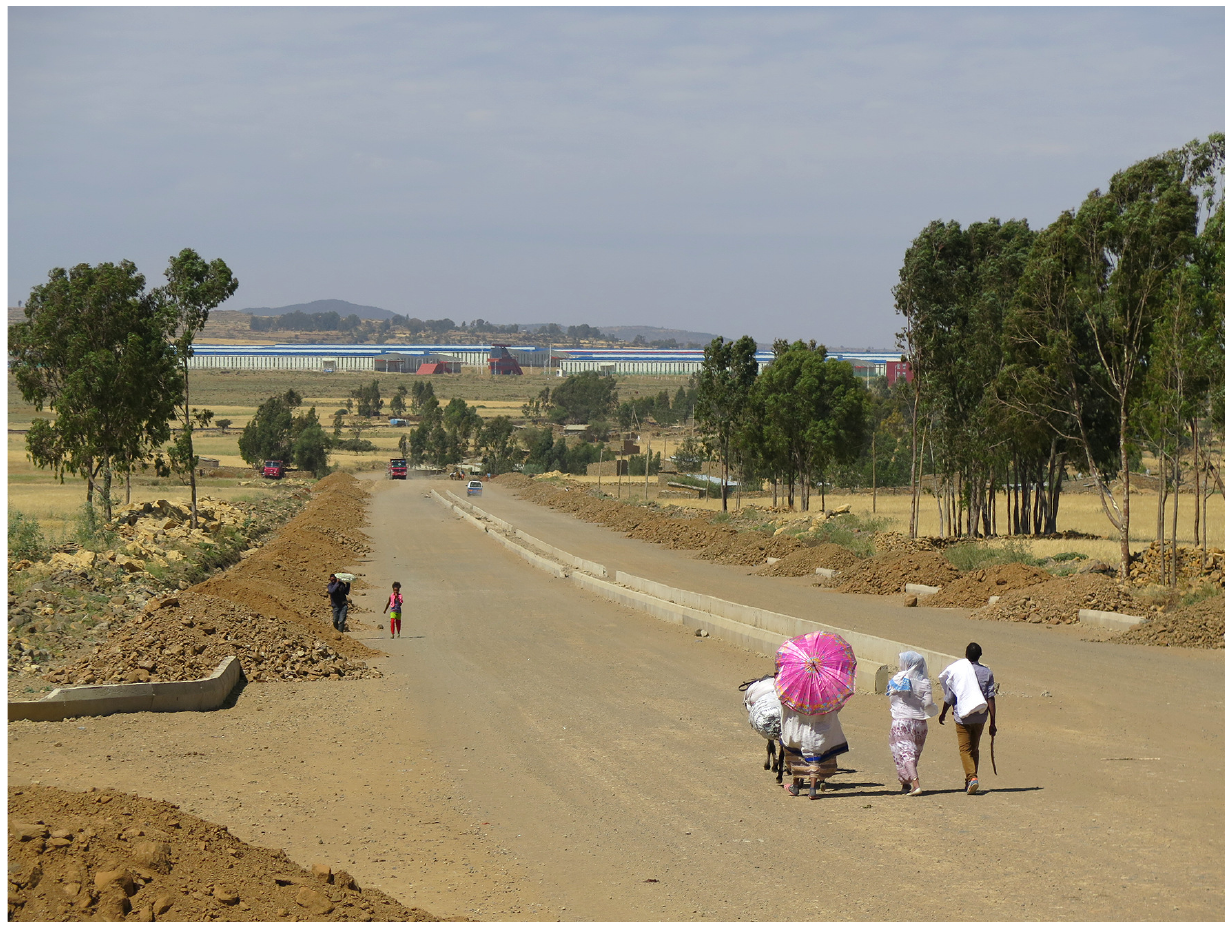
Figure 4. MIP and bypass under construction